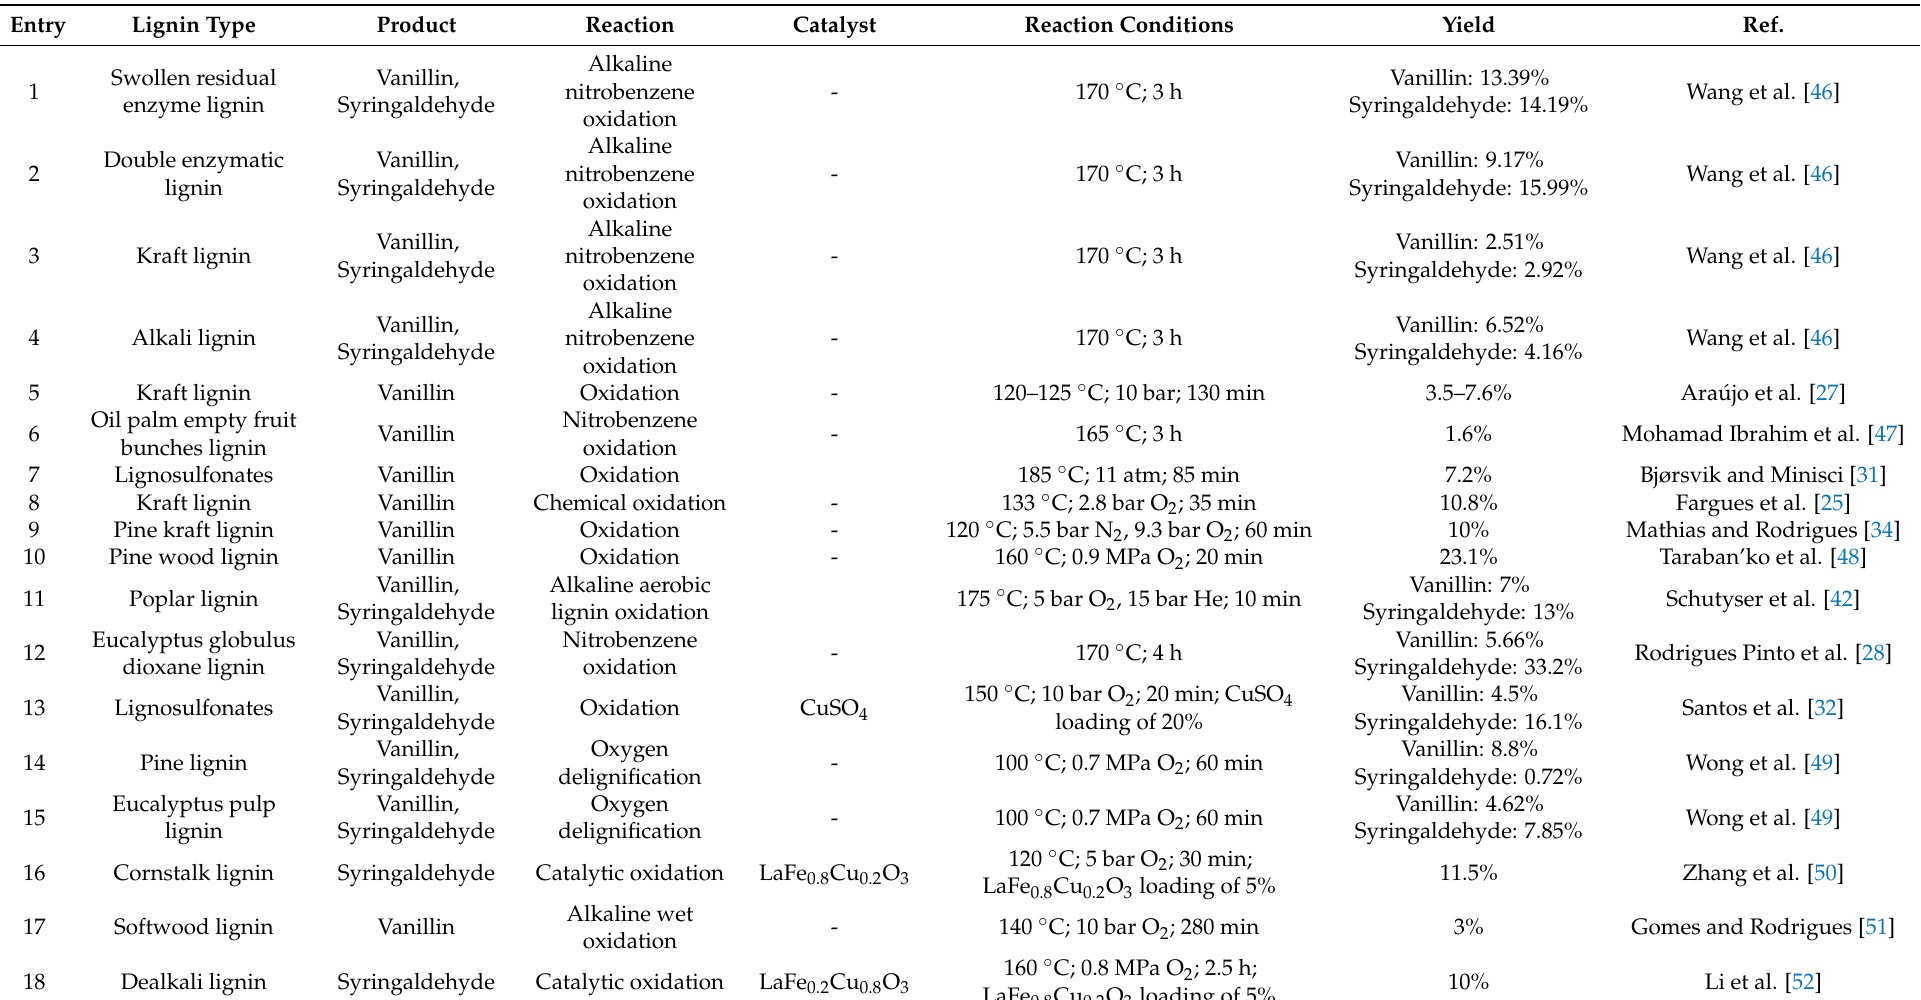
Table 1. Alkaline aerobic oxidation of different lignin